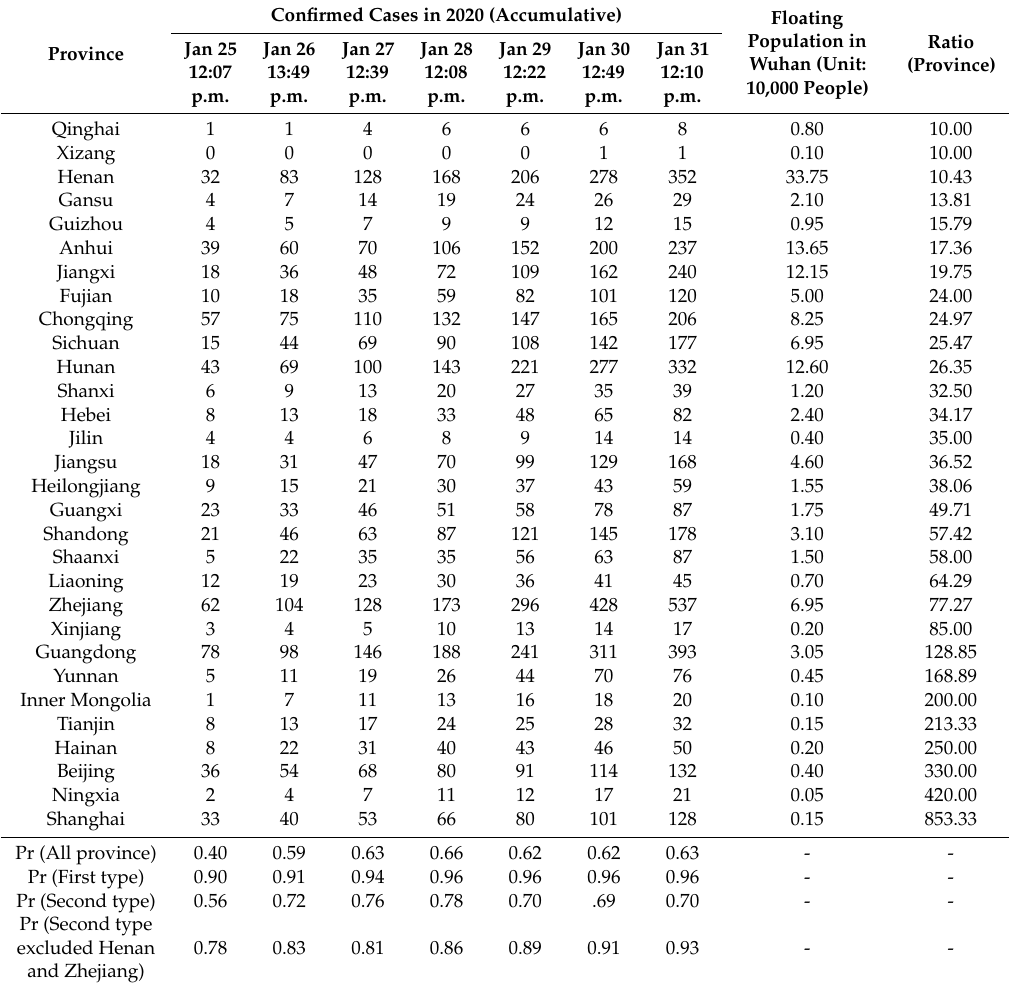
Table 10. 2019-nCoV confirmed cases and floating population from Wuhan in China.